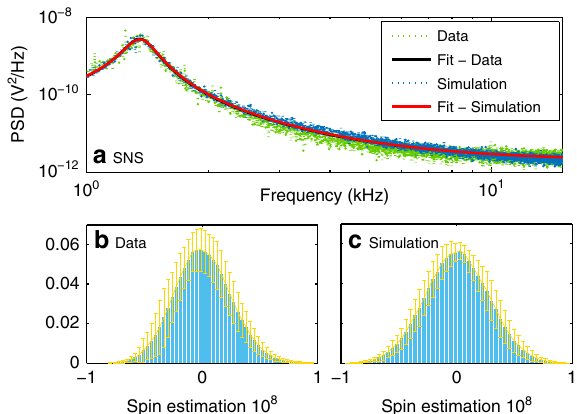
Fig. 9 Kalman model validation based on real data (Data) and simulated data (Simulation). a Spin noise spectroscopy (SNS) of Data (blue dots) and Simulation (green dots). The Lorentz fi ttings of Data (black line) and Simulation (red line) are totally overlapped. The spin distributions (see text) from Data ( b ) and Simulation ( c ) are shown as histograms. Error bars indicate plus/minus one standard deviation of histograms of 20 traces. Probe power = 2 mW, ν L = 1.3 kHz.